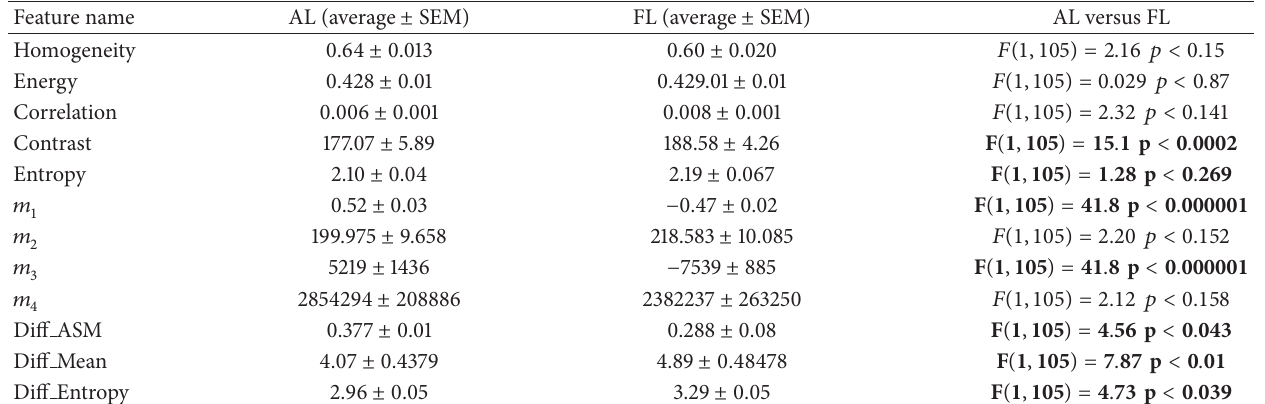
Table 2: ANOVA (1 within-subject factor) results for edema patients Haralick texture features (comparison between AL and FL). AL: affected lung; FL: fellow